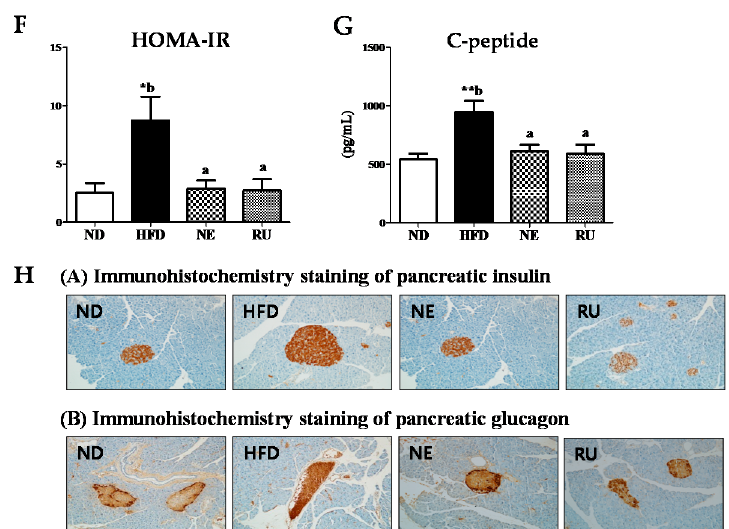
Figure 3. Effect of NE and RU supplementation for 16 weeks on fasting blood glucose ( A ), glucose tolerance ( B ), area under the curve (AUC) ( C ), plasma glucose ( D ) and insulin ( E ) levels, HOMA-IR ( F ), c-peptide level ( G ), and pancreatic immunohistochemistry analysis (200 × magnification) ( H ) in C57BL/6J mice fed high-fat diet. Data are mean ± S.E. Significant differences between HFD versus ND are indicated; * p < 0.05, ** p < 0.01, *** p < 0.001. ab Means not sharing a common superscript are significantly different among the high-fat diet fed groups at p < 0.05. HOMA-IR, homeostatin model assessment-insulin resistance; C-peptide, connecting peptide.